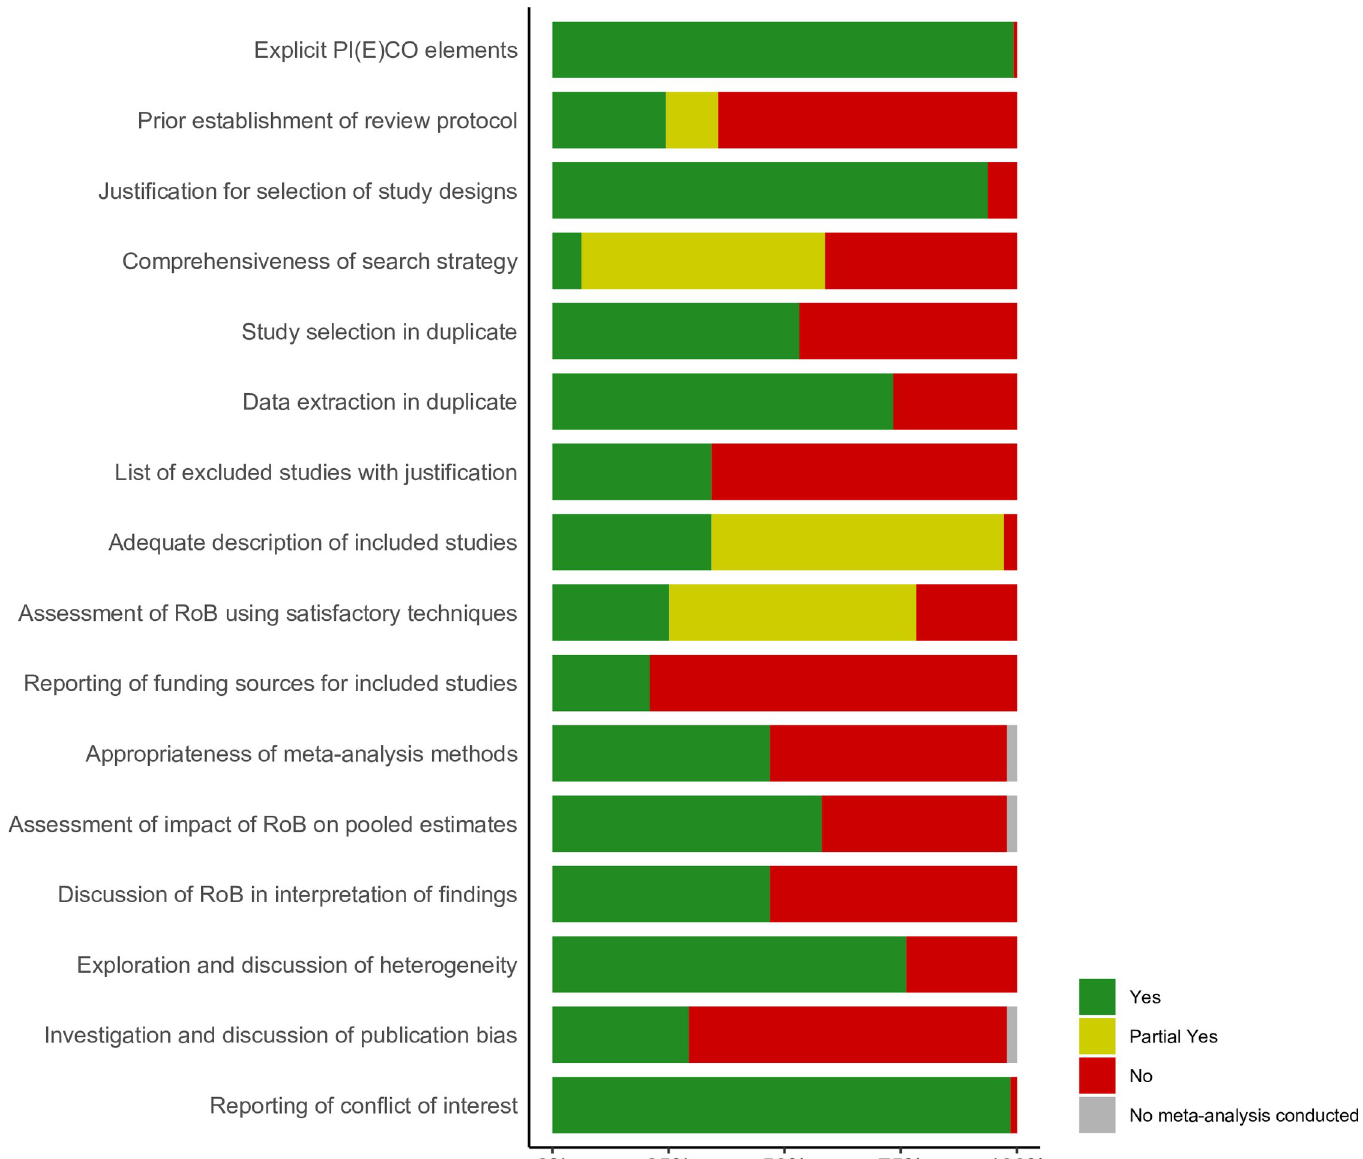
Fig 2. Quality assessment by outcome presented as percentages across all included systematic reviews. PI(E)CO, Population, Intervention or Exposure, Comparator, Outcome; RoB, risk of